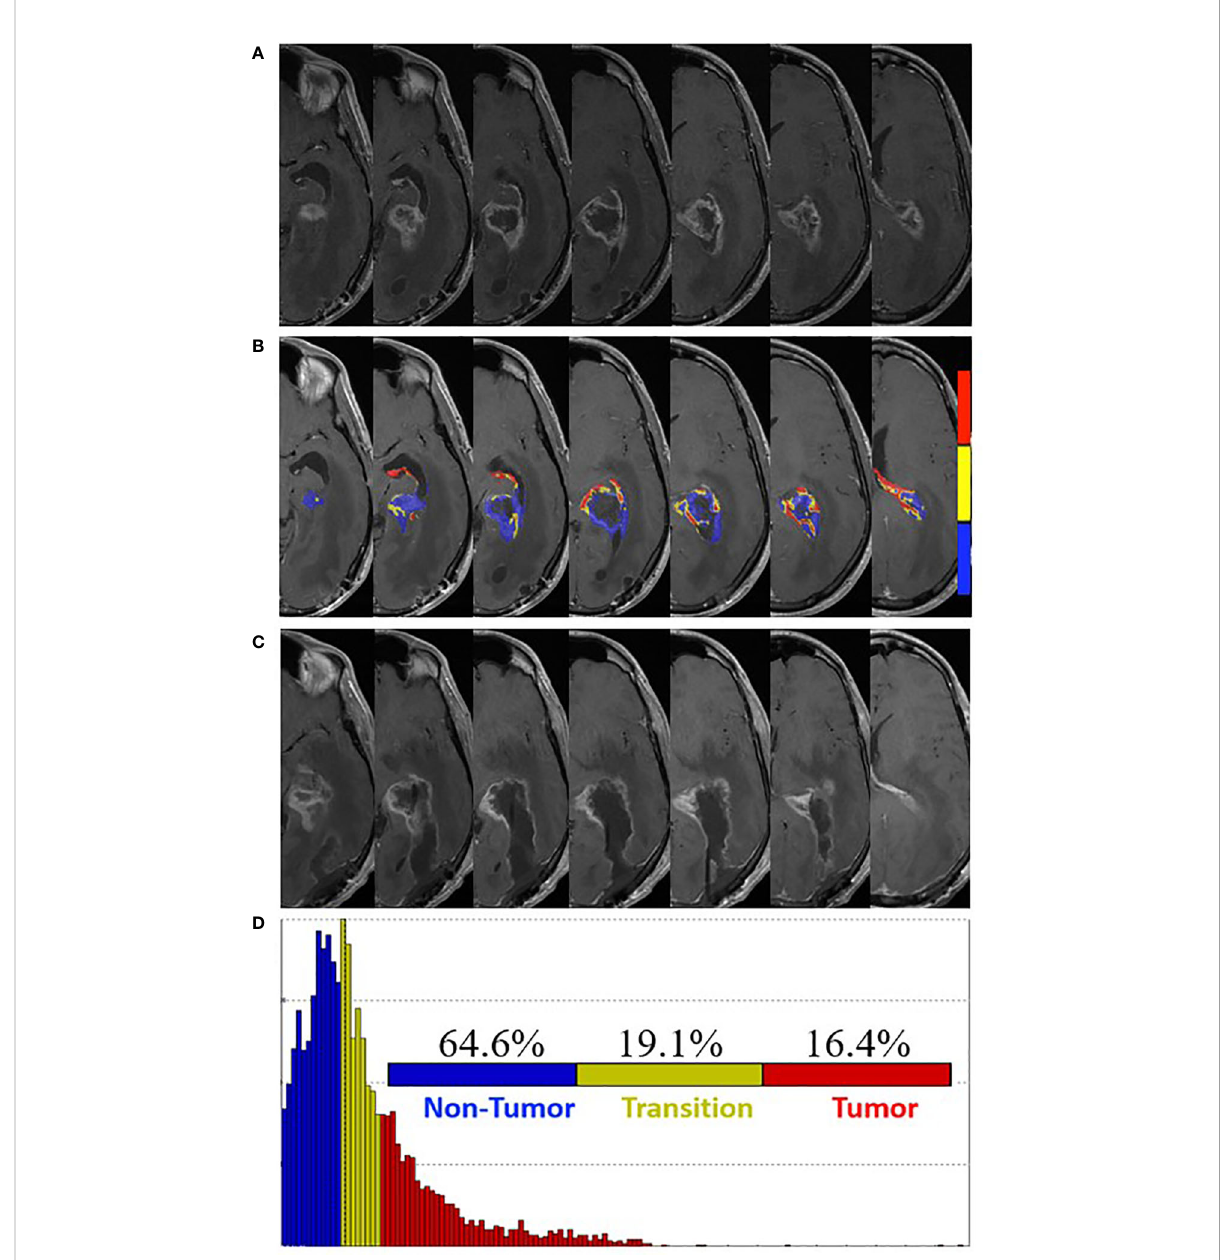
FIGURE 3 Pre- and post-surgery MRI. (A) Postcontrast T1-weighted MRI obtained four weeks post-pLDR treatment and one week before redo- surgery. (B) Corresponding maps of FTB superimposed on the postcontrast T1-weighted MRI images. The FTB maps show areas of active tumor (red), treatment effect (blue), and transitional zone (yellow). (C) Post-surgery (one week) postcontrast T1-weighted MRI demonstrating extent of resection. (D) Distribution of T1-weighted enhancement volume based on vascularization as measured by FTB